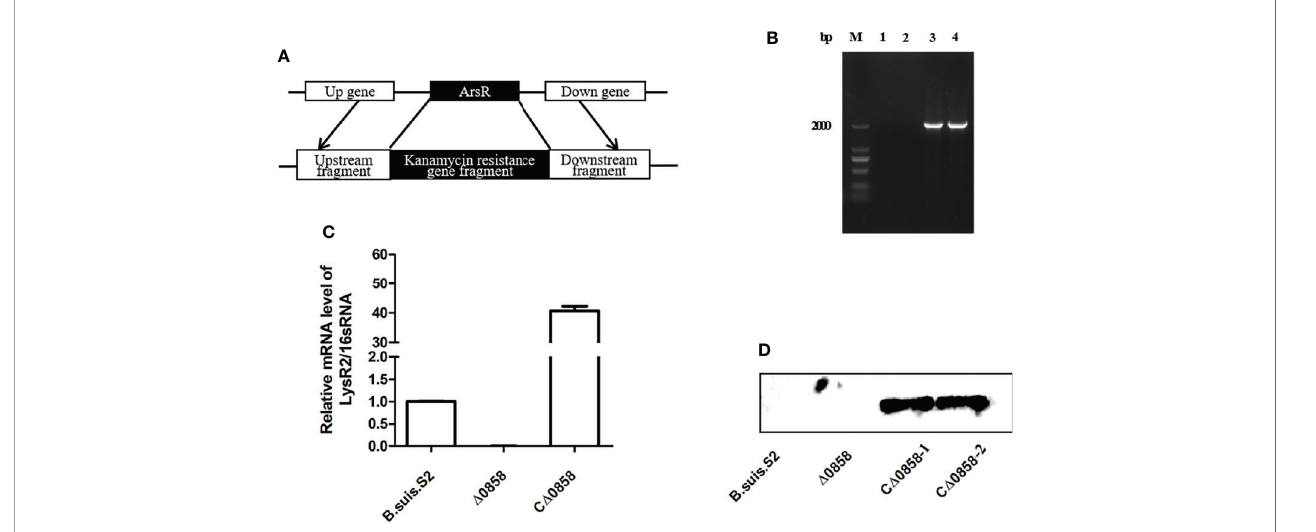
FIGURE 1 | BSS2_II0858 deletion mutant and complementation strains were successfully constructed. (A) Schematic of the construction of the BSS2_II0858 mutant strain. (B) Identi fi cation of the BSS2_II0858 mutant by PCR ampli fi cation. Lanes: 1, the gene upstream of BSS2_II0858 and the kanamycin resistance gene in B. suis S2; 2, the gene downstream of BSS2_II0858 and the kanamycin resistance gene in B. suis S2; 3, the gene upstream of BSS2_II0858 and the kanamycin resistance gene in the BSS2_II0858 mutant strain; and 4, the gene downstream of BSS2_II0858 and kanamycin resistance gene in the BSS2_II0858 mutant strain. (C) qRT-PCR con fi rmed the mRNA expression of BSS2_II0858 in the B. suis S2, BSS2_II0858 mutant, and complementation strains. (D) The inducible expression of fl ag-tagged BSS2_II0858 was detected by Western